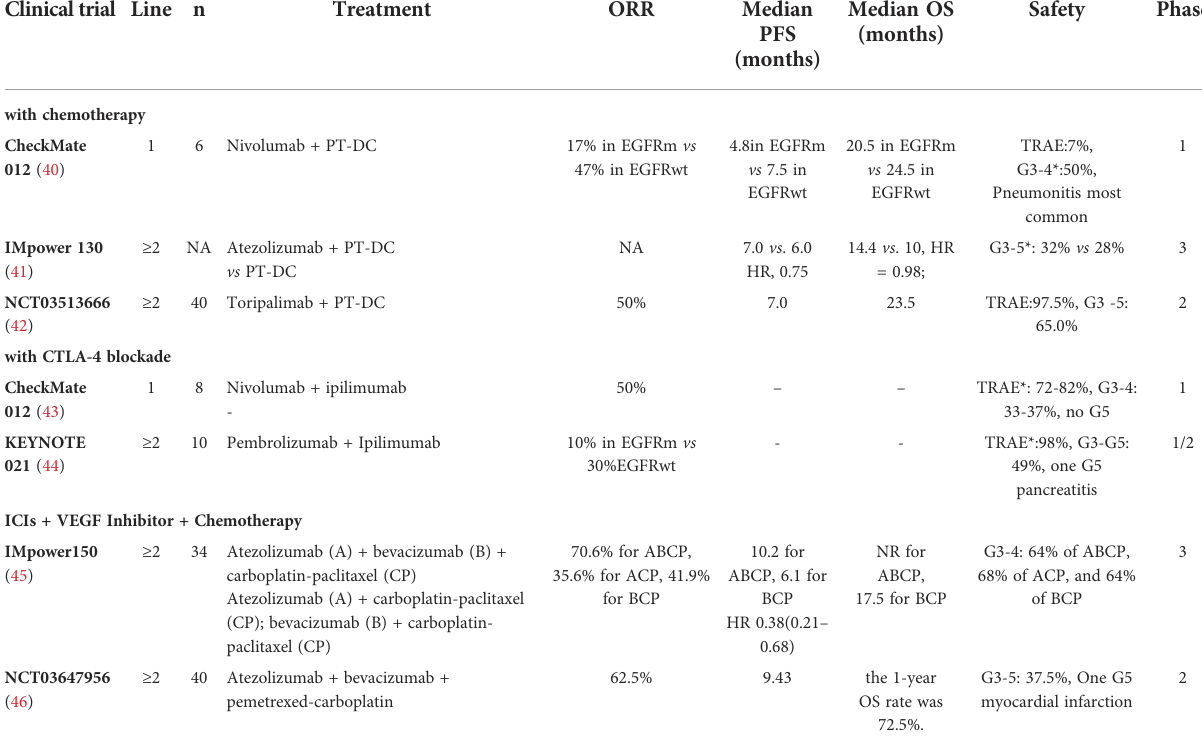
TABLE 2 ICI-based immunotherapy combinations for EGFR-mutant NSCLC patients. Clinical trial Line